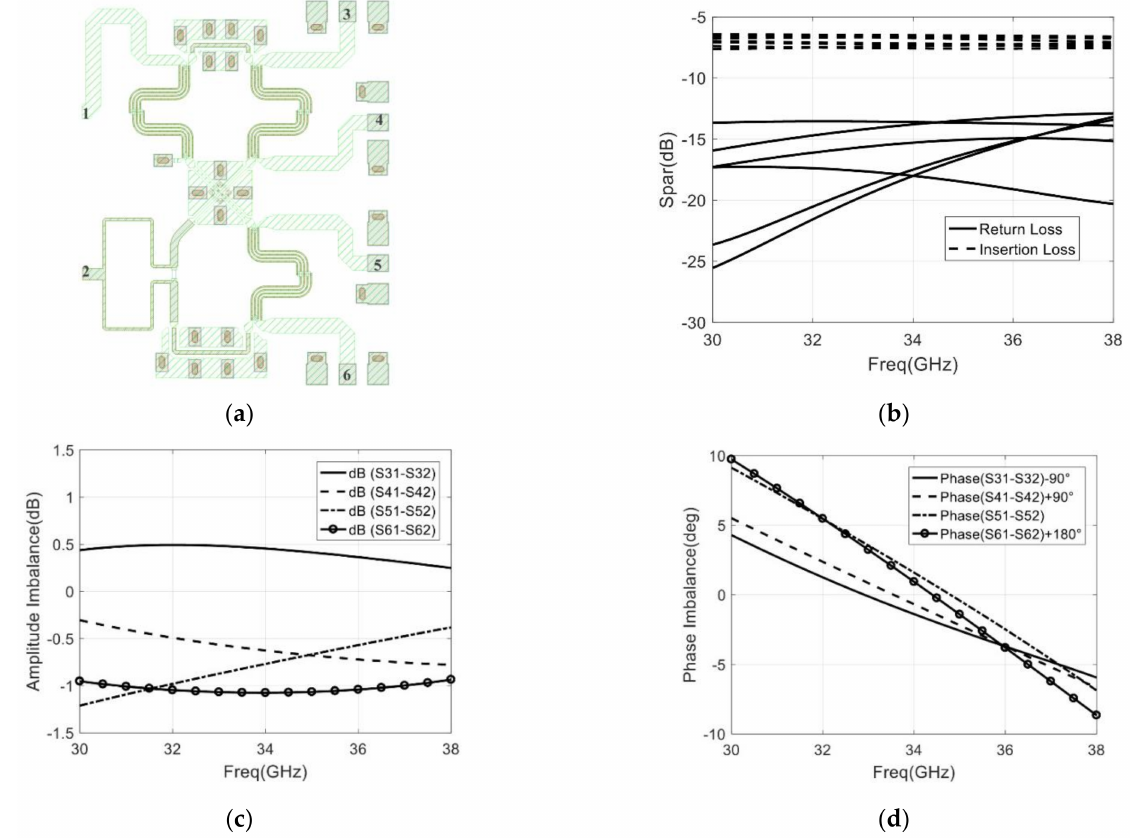
Figure 14. The designed six-port network: ( a ) Layout design; ( b ) Simulation of return loss and insertion loss; ( c ) Simulation of the amplitude imbalance; ( d ) Simulation of the phase